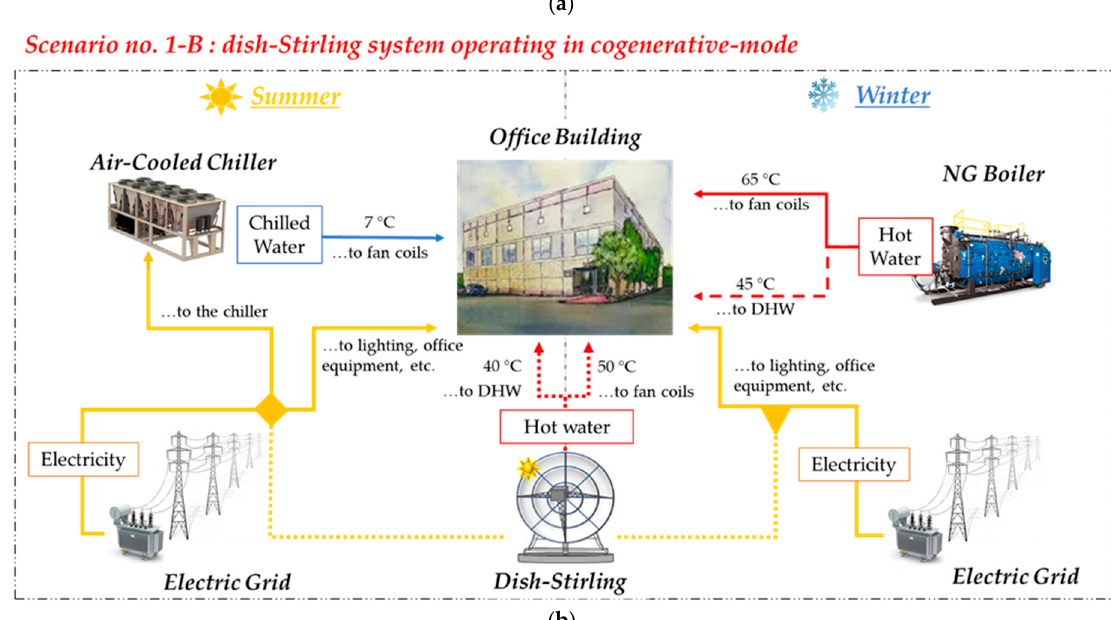
Figure 7. Improved scenarios for System no. 1: ( a ) dish-Stirling system operating in electric-mode, and ( b ) dish-Stirling system operating in cogenerative-mode.